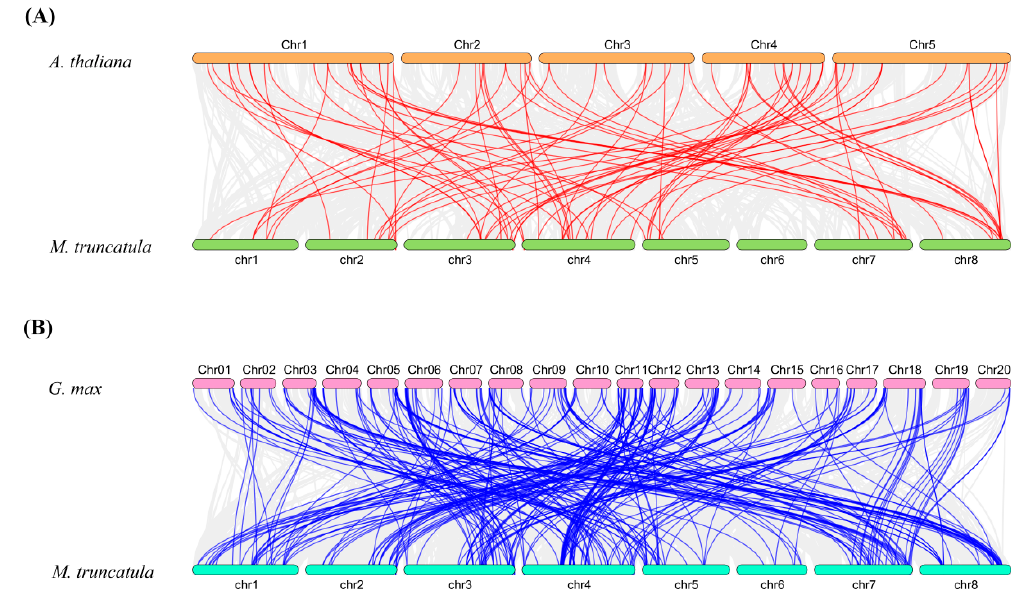
Figure 4. Synteny analysis of MtSDR genes in the genomes between M. truncatula and A. thaliana or G.max . ( A ) M. truncatula and A. thaliana ; ( B ) M. truncatula and G.max. The gray lines show collinear blocks. The red and blue lines indicate the syntenic gene pairs between M. truncatula and A. thaliana or G. max , respectively .